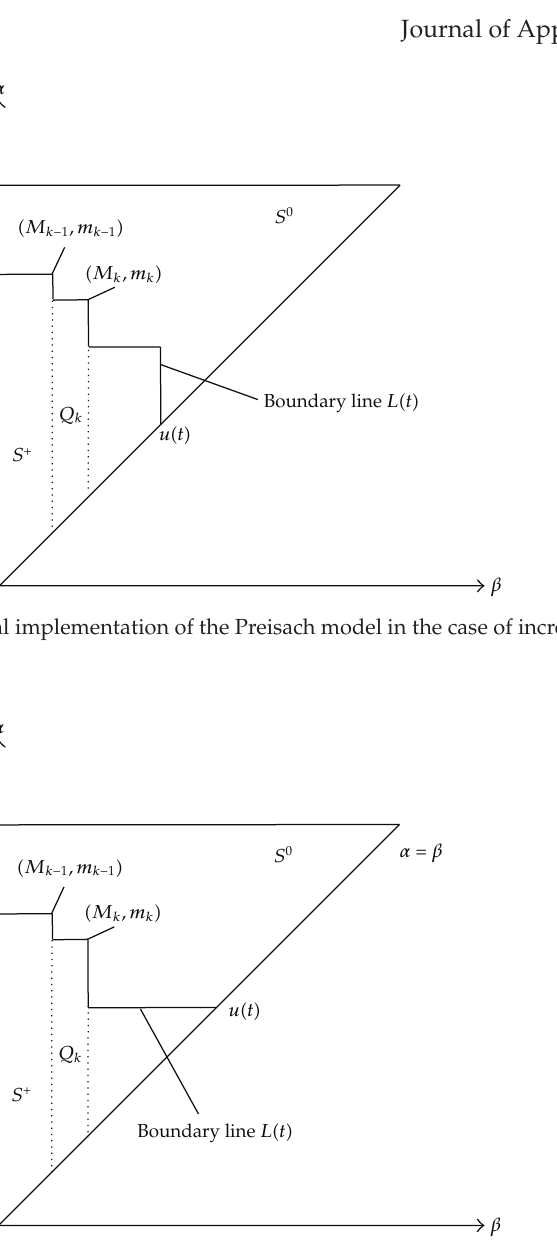
Figure 8: Numerical implementation of the Preisach model in the case of decreasing